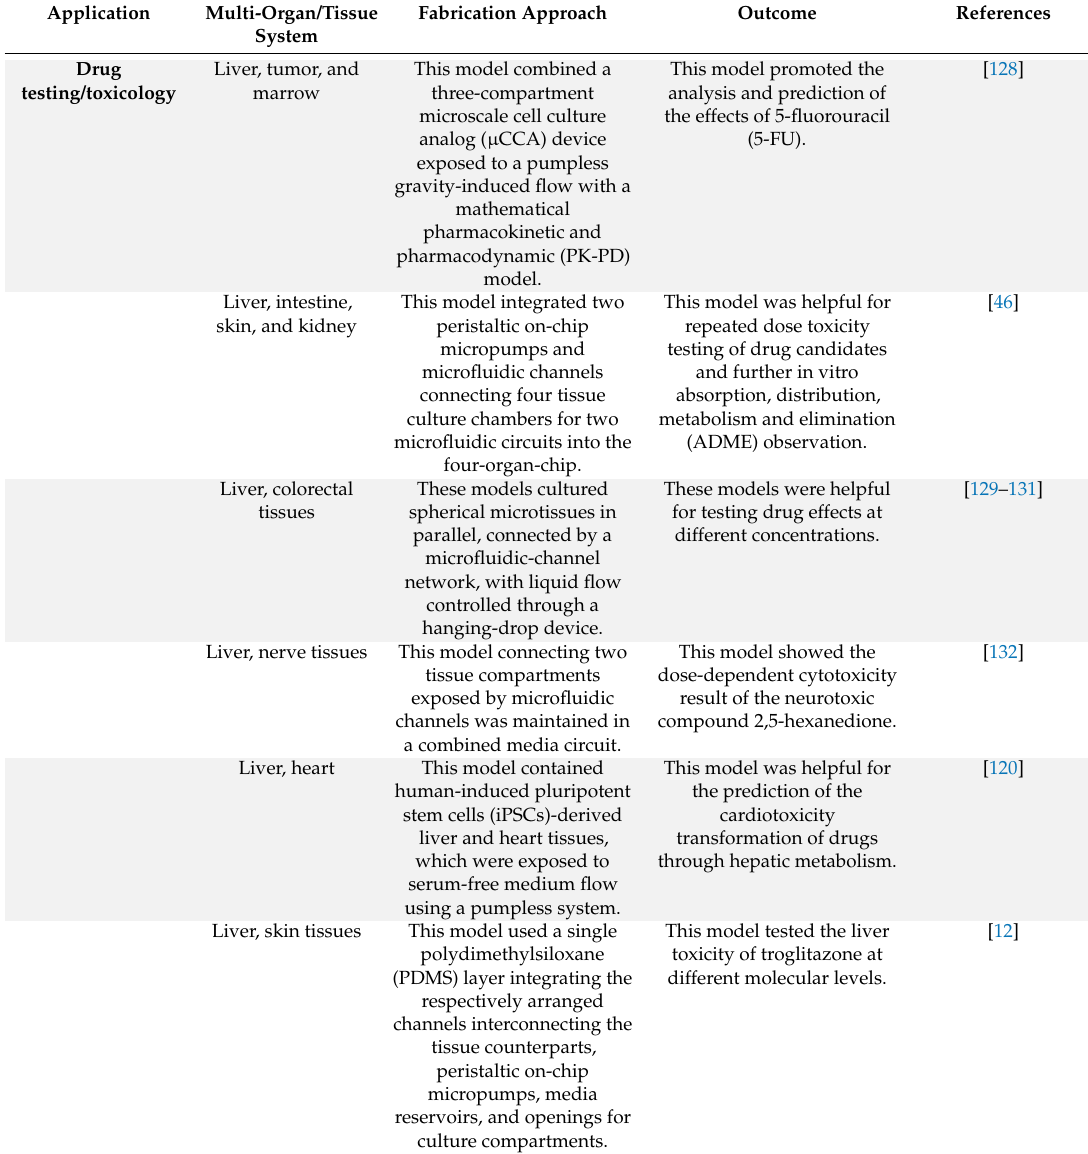
Table 1. Biomedical applications of MOC